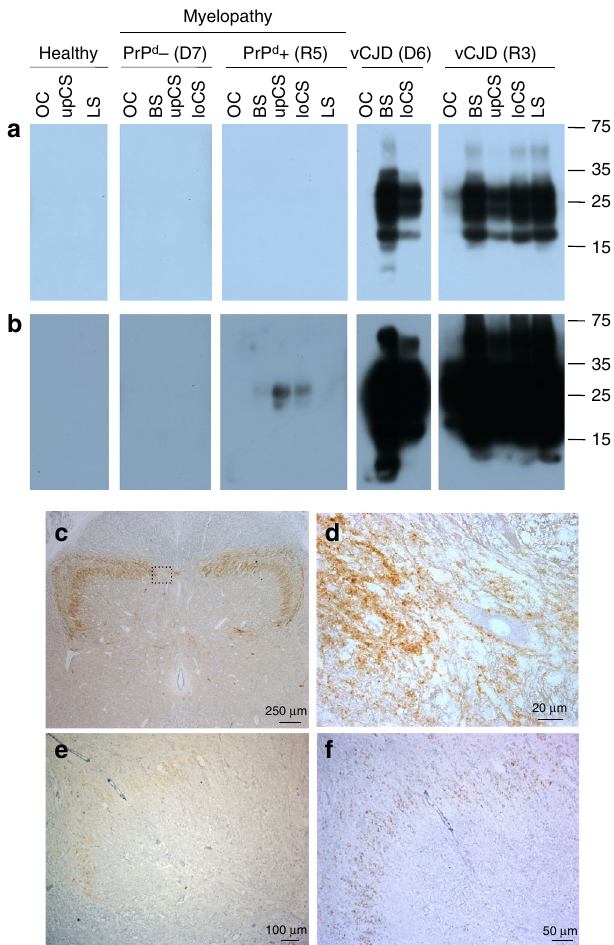
Fig. 5 Detection of PrP in R5 myelopathic primate. Detection of PK-resistant abnormal PrP in myelopathic primates D7 and R5, and vCJD primates D6 and R3 by western blot analysis with Sha-31 anti-PrP antibody, after short- term ( a ) or long-term ( b ) exposure. OC occipital cortex, BS brainstem, upCS upper cervical cord; loCS lower cervical cord, LS lumbar cord. c Detection of abnormal PrP d deposits in spinal cord (12th thoracic level) of R5 primate with Sha-31 monoclonal antibody (50×). d Higher magni fi cation of c showing perineuronal and synaptic PrP immunostaining (630×). e Detection of abnormal PrP d deposits in spinal cord (4th cervical level) of R5 primate with POM-1 monoclonal antibody (100×). f Detection of abnormal PrP d deposits in spinal cord (4th cervical level) of R5 primate with 12F10 monoclonal antibody